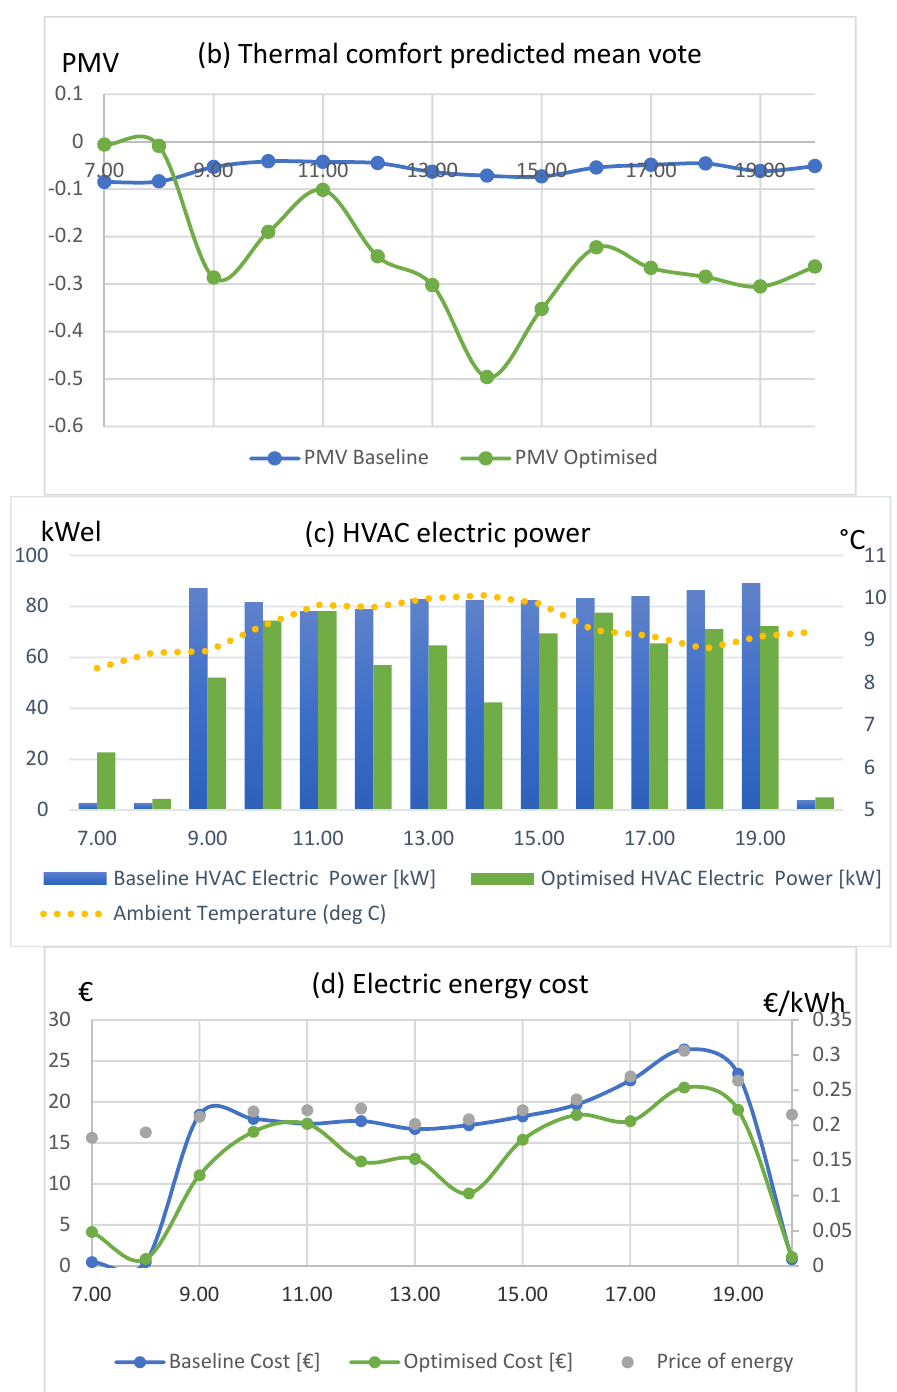
Figure 8. GA HVAC optimization results for 20 November 2018 (winter).